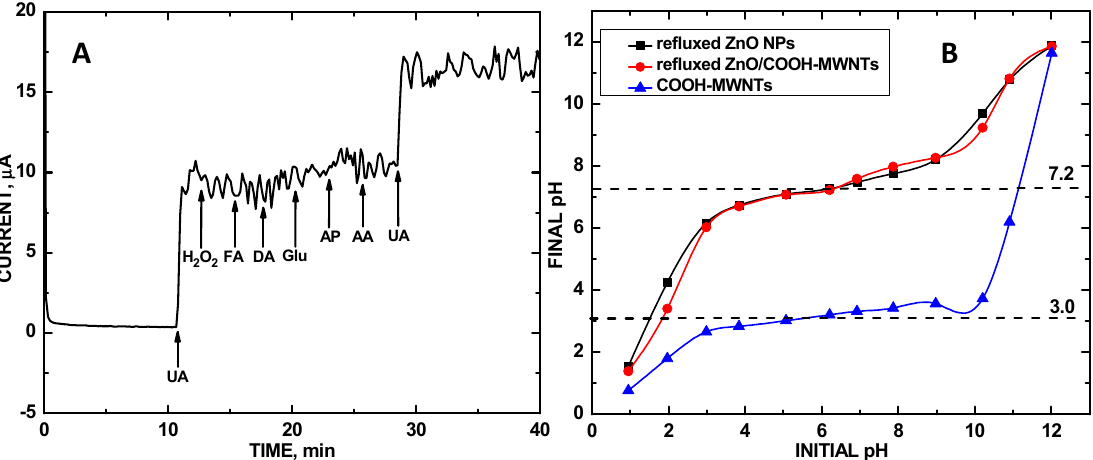
Figure 7. ( A ) CA response of the Nafion/ZnO/COOH-MWNTs/GCE at 0.577 V vs. Ag/AgCl electrode upon 100 µ M additions of UA, FA, AA, DA, H 2 O 2 , AP, and UA, respectively; ( B ) point-of-zero (PZC) values of refluxed ZnO NPs (- ■ -), refluxed ZnO/COOH-MWNTs (- ● -) and COOH-MWNTs (- ▲ -).